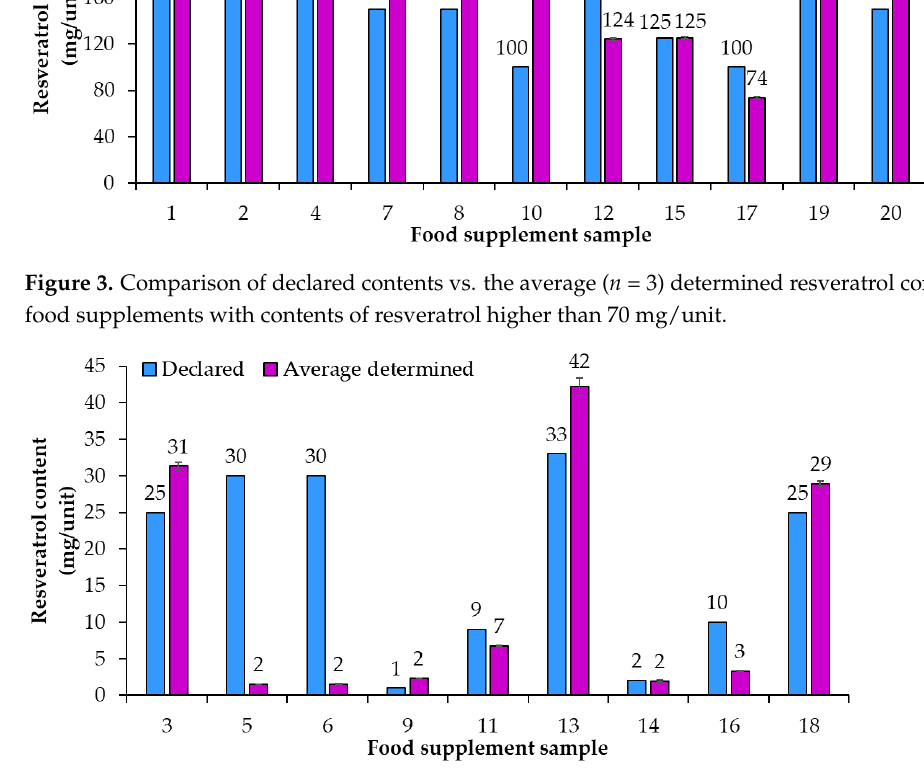
Figure 4. Comparison of declared contents vs. the average ( n = 3) determined resveratrol contents in food supplements with contents of resveratrol lower than 50 mg/unit.